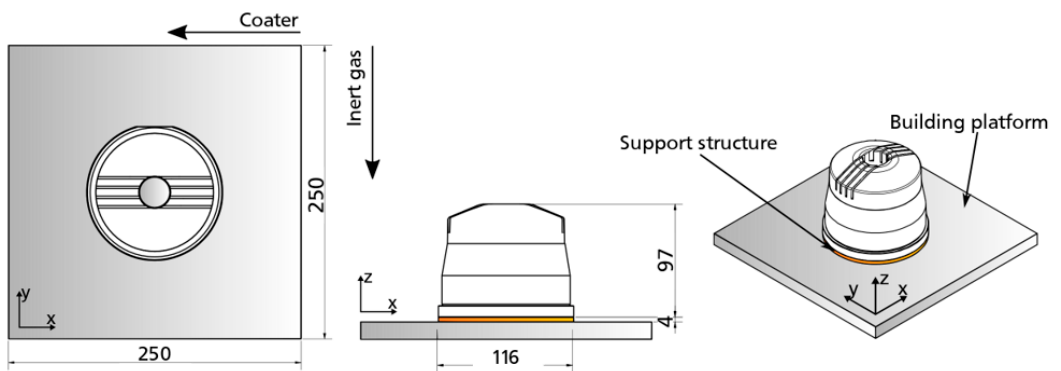
Figure 18. 3D sectional model of the injection molding tool from two perspectives.